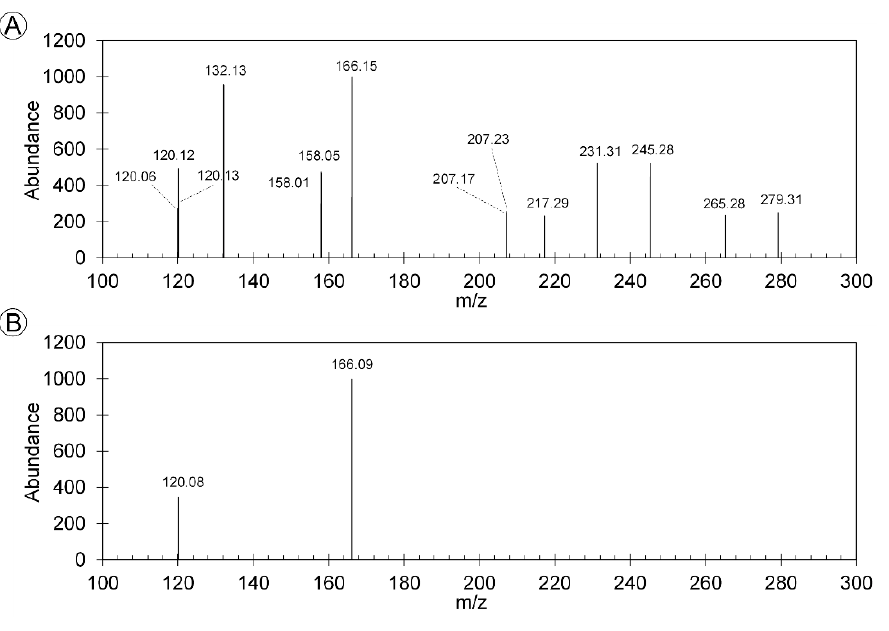
Figure 9. Spectra of ESI-MS. ( A ) demineralized stalactite minerals by 6M HCl; ( B ) phenylalanine [36,37] by MassBank.